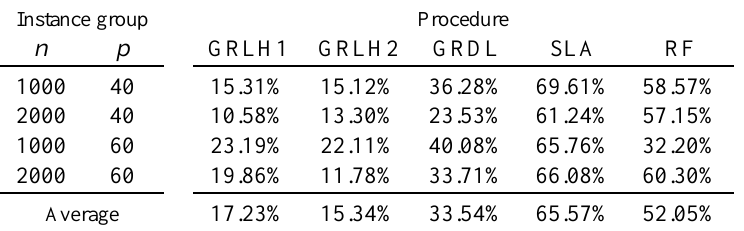
Table 8. Relative deviation for infeasibility results with greedy constructive procedures.